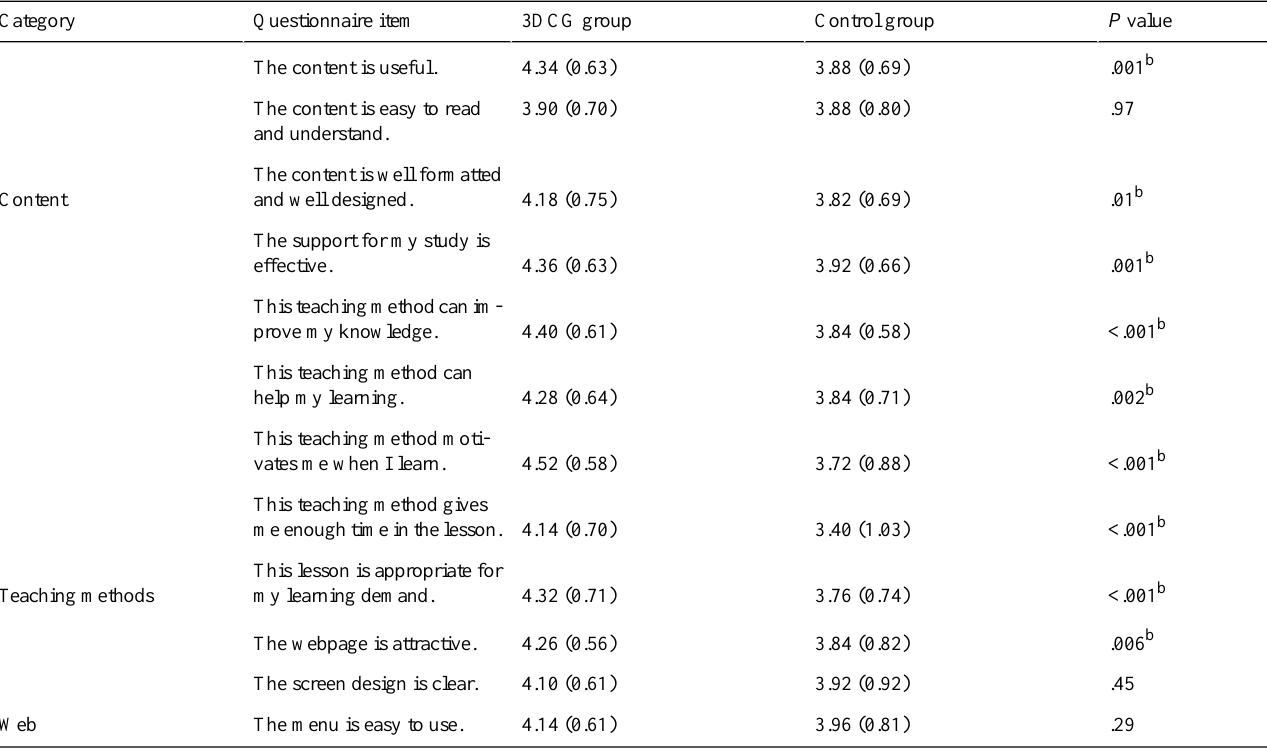
Table 4. Comparison of mean (SD) questionnaire scores a between 3-dimensional computer graphics (3D G) and control groups.